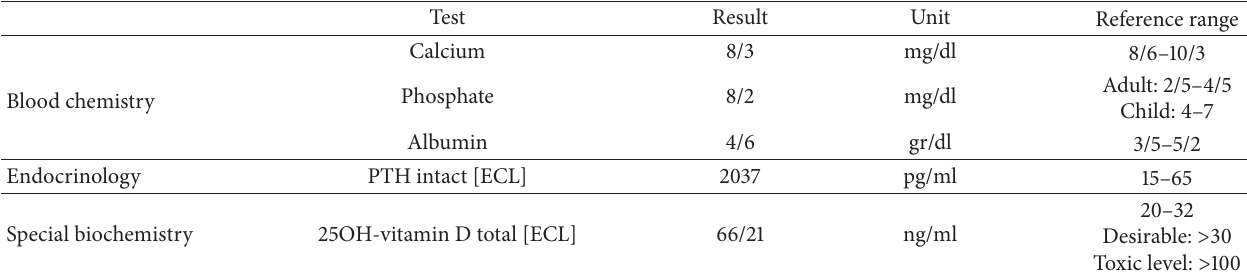
Table 1: Laboratory tests of patients showing